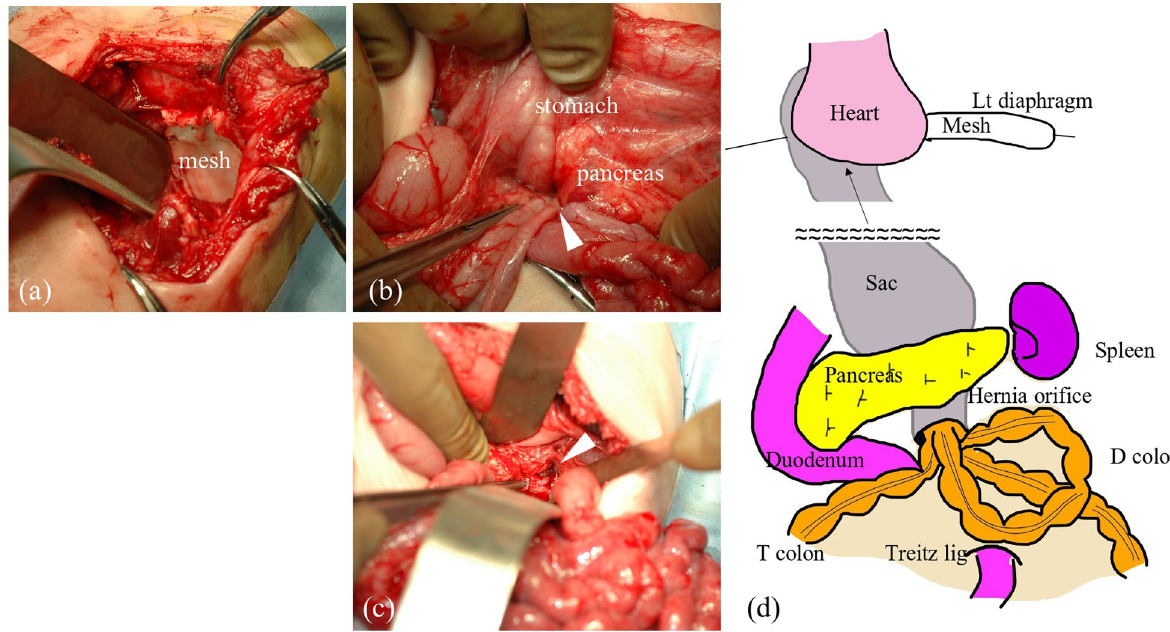
Fig. 4 Intraoperative findings in case 1. a No apparent defect hole at the diaphragm. b Transverse colon protrudes into the absence of retropancreatic fascia (arrowhead). c The absent site of retropancreatic fascia is suture closed. d Schema shows the hernia sac protrudes from the absence of retropancreatic fascia into the posterior mediastinum